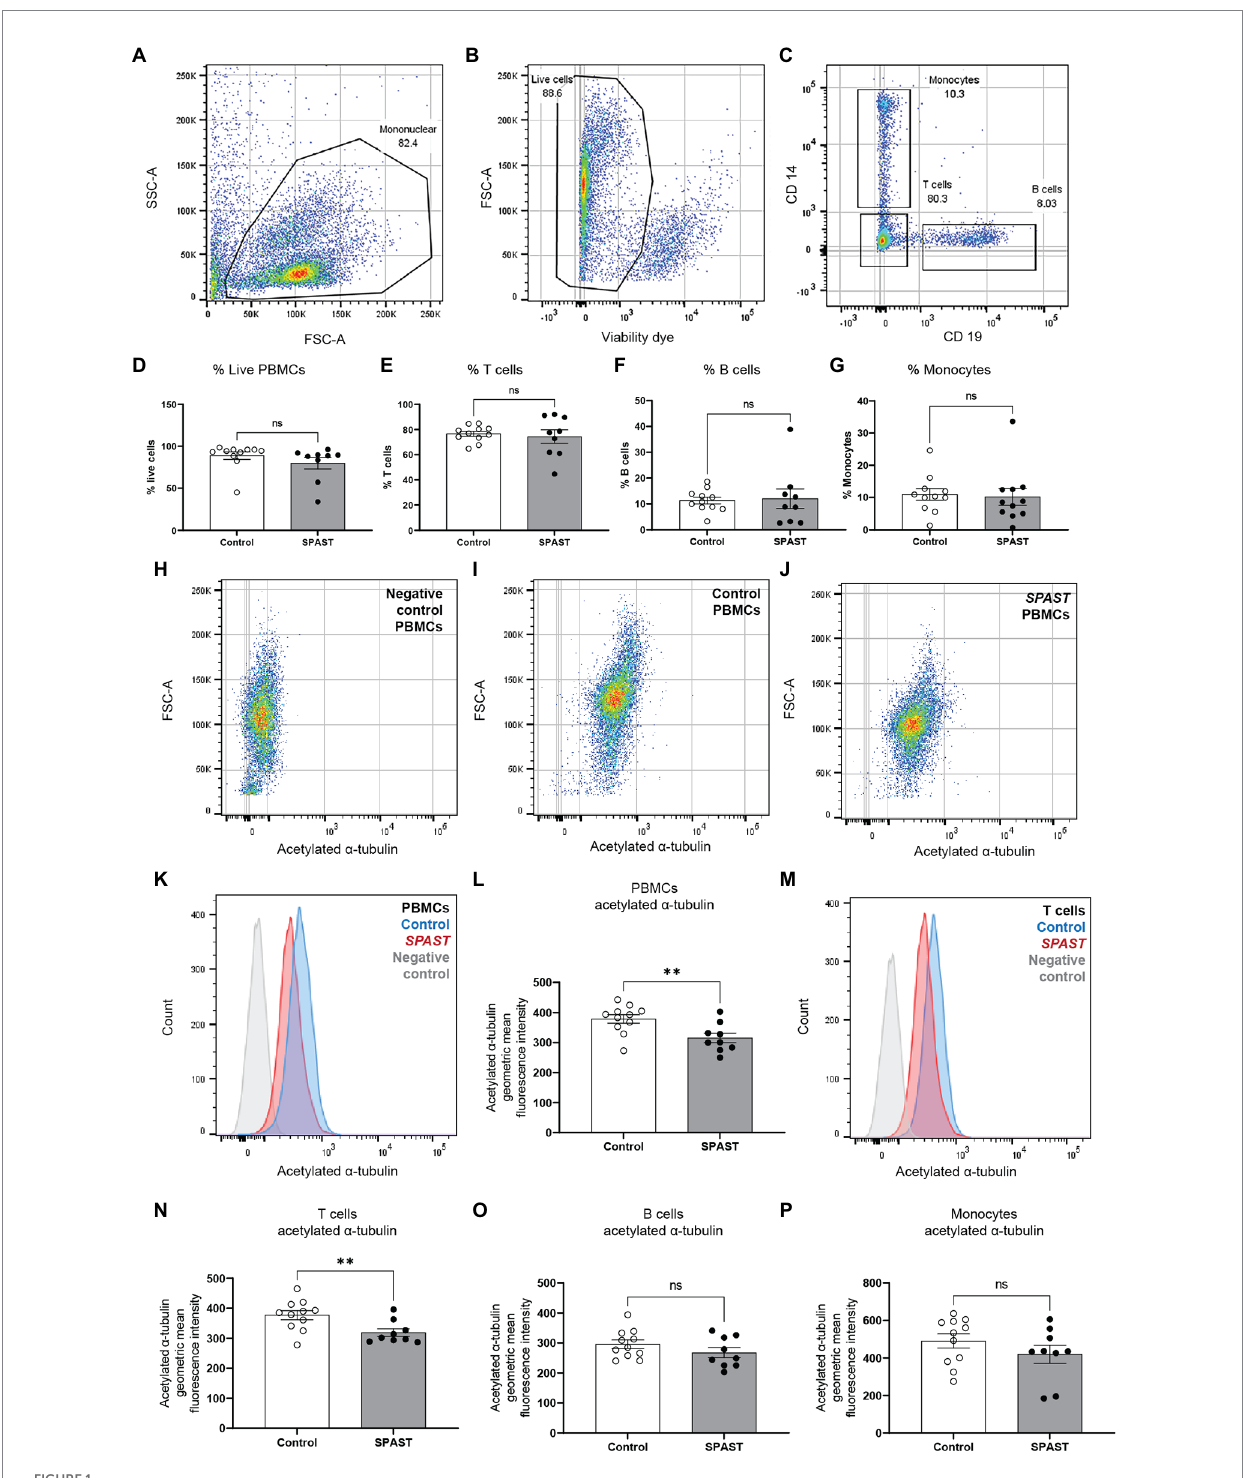
FIGURE 1 Acetylated α -tubulin levels in SPAST HSP patient and control PBMCs. Flow cytometry was used to measure acetylated α -tubulin in overall PBMCs and PBMC cell sub-types. (A) The forward-scatter and side-scatter (FSC/SSC) gated plots represent the total mononuclear cells. (B) Live PBMCs were identified using a cell viability dye. Viable cells have a relatively lower fluorescence level of the viability dye and vice versa for non-viable cells. Gating was applied to identify the proportion of viable cells. (C) CD2, CD19, and CD14 cell surface antibodies were used to identify PBMC cell sub-types T cells, B cells and monocytes. The scatter plot shows CD14 monocytes and CD19 B cells separated using the surface antibodies. The proportion of live PBMCs (D) and the proportion of T cells (E) , B cells (F) and monocytes (G) is shown for all HSP -SPAST patients and healthy controls. (H–J) Levels of acetylated α -tubulin in PBMCs were measured in patient and control PBMC samples. Scatter plot of an acetylated α -tubulin negative control sample (H) and representative control (I) and patient (J) samples are shown. (K) Histogram plot showing acetylated α -tubulin levels in representative patient and control PBMC samples. (L) Patient and control group level comparison based on acetylated α -tubulin geometric mean fluorescence intensity in all PBMCs. (M) Histogram plot showing acetylated α -tubulin levels in representative patient and control T cells. Patient and control group level comparison of T cells (N) , B cells (O) and monocytes (P) based acetylated α -tubulin geometric mean fluorescence intensity. Mean ±